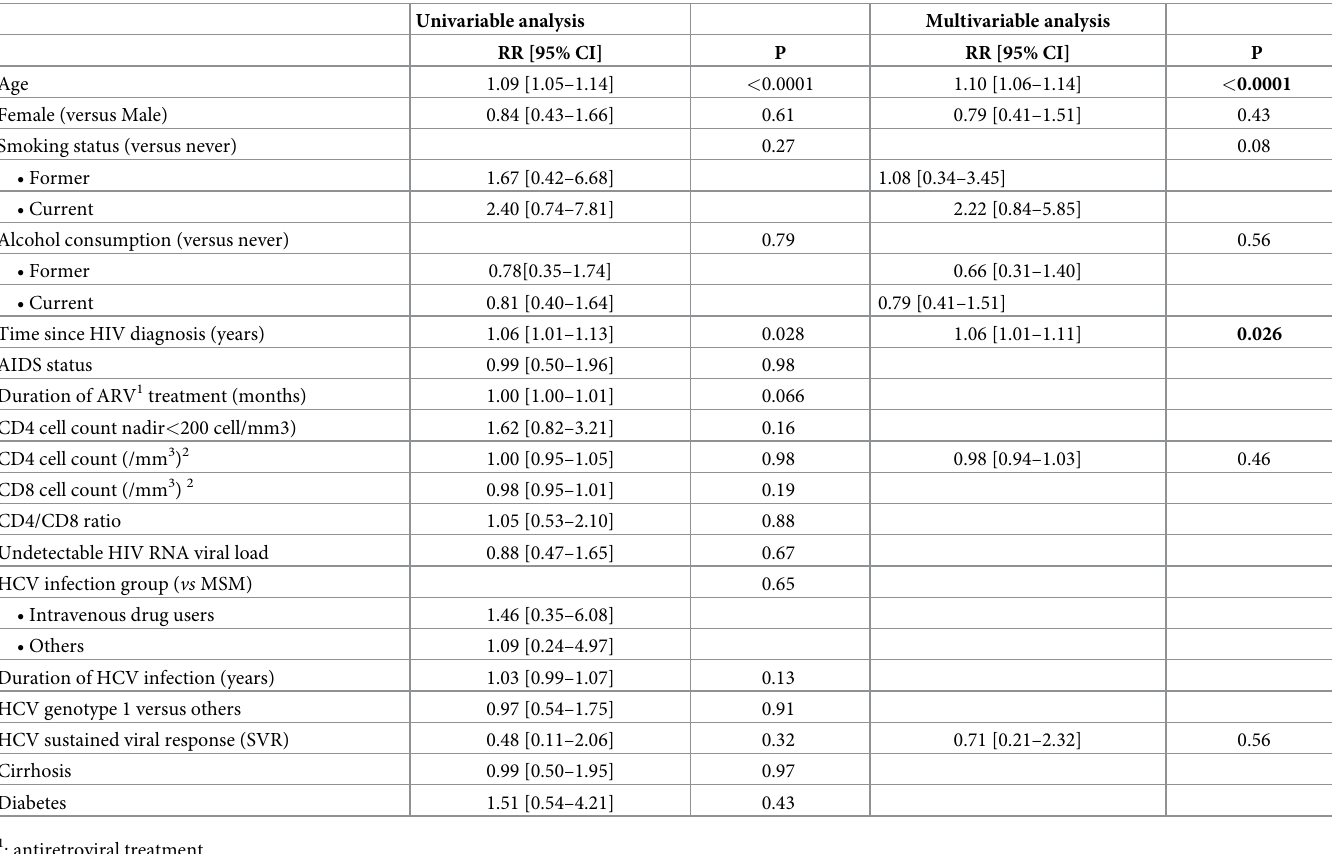
keeping with previous reports showing that the most important risk factors for non-AIDS- defining cancers were advancing age and the duration of HIV infection, age and the time since HIV diagnosis, after adjustment for other factors, were the only factors found to be indepen- dently associated with a higher risk of developing NANL related cancers in our study [2]. Table 3. Factors associated with non-AIDS-defining cancers and non HCV-liver related cancers among HIV/HCV-coinfected patients—Univariate and multivariate analyses from the ANRS CO13 HEPAVIH Cohort (N =